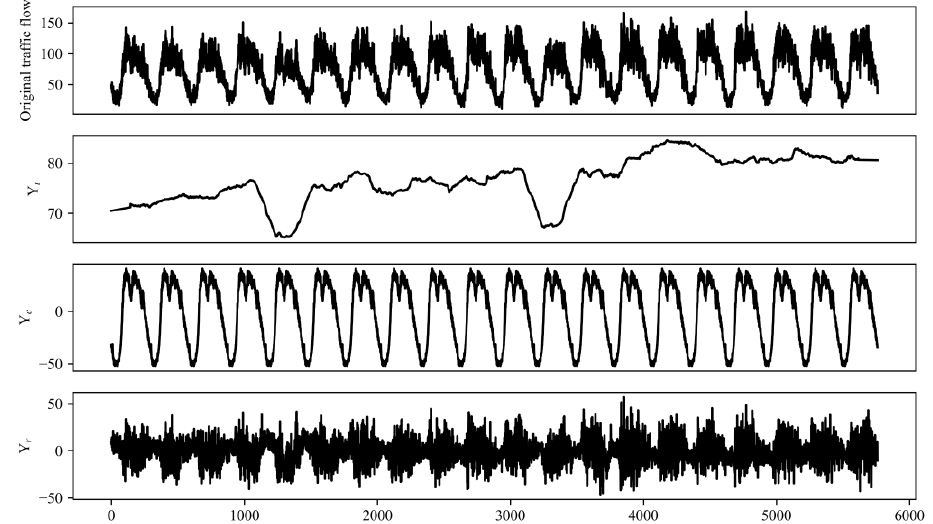
Figure 6. STL decomposition results.